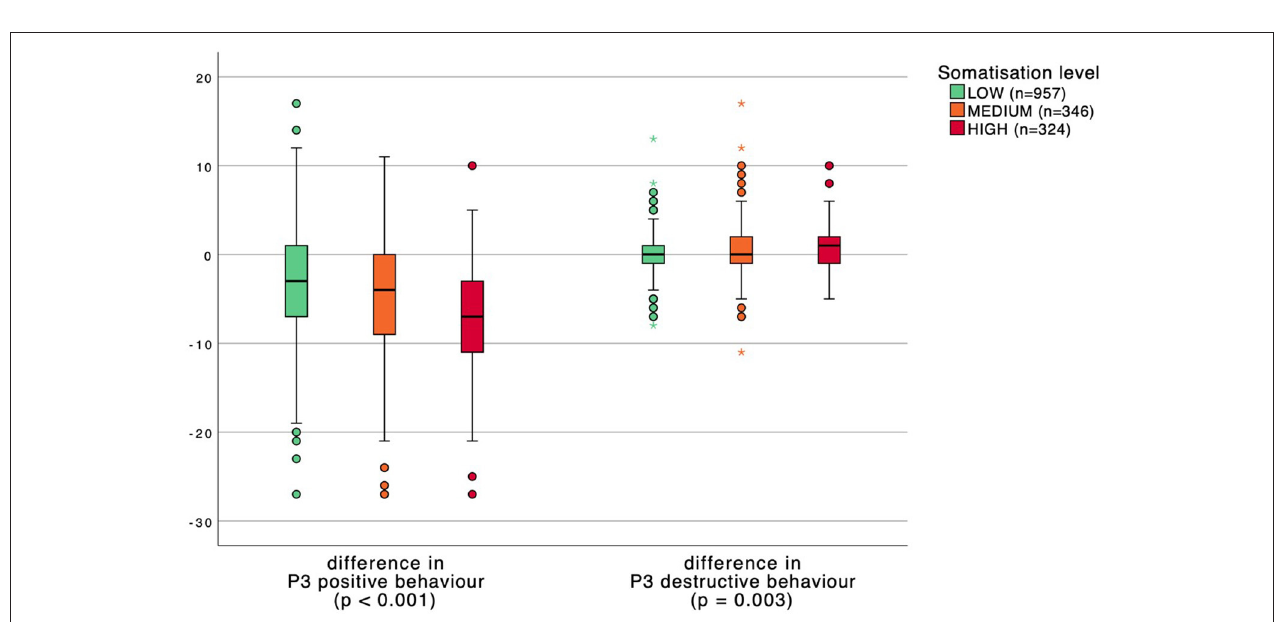
FIGURE 2 | Boxplot comparing P3 behavior scores between somatization levels. p -values calculated with a one-way ANOVA test.